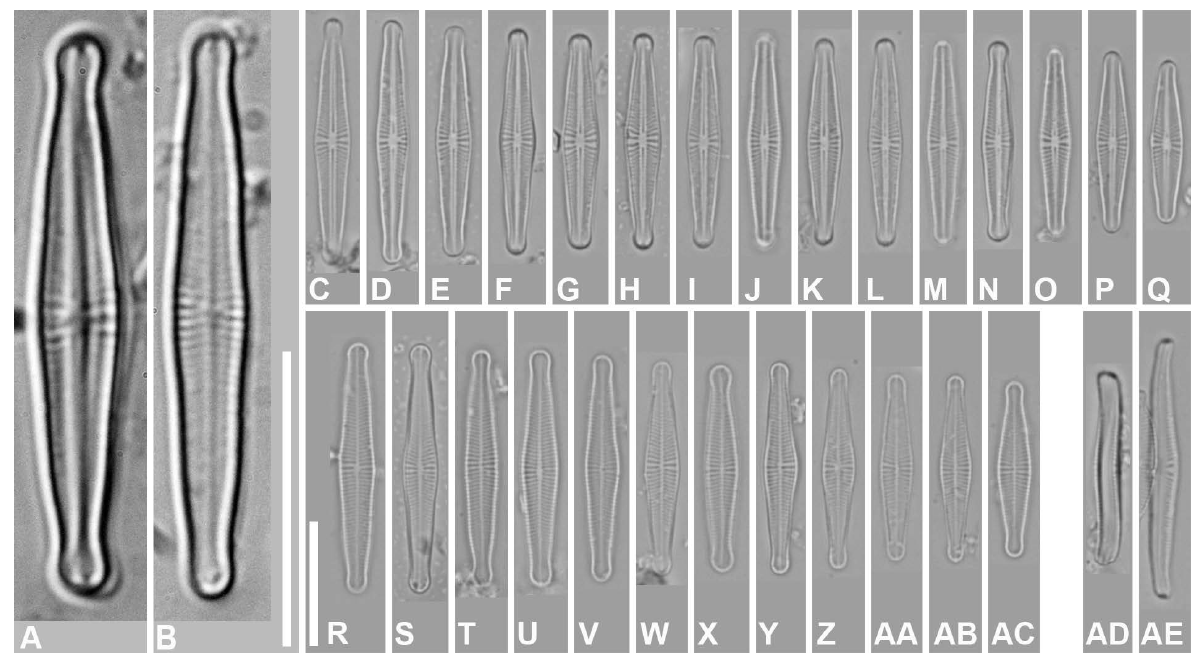
Figure 5. Achnanthidium dumlupinarii sp. nov., LM micrographs. A , C – Q . views of raphe valves. B , R – AC . Views of rapheless valves. AD , AE . Views of raphe valves in girdle view. Scale bar = 10 µm (A, B: 2500×; C–AE: 1000×